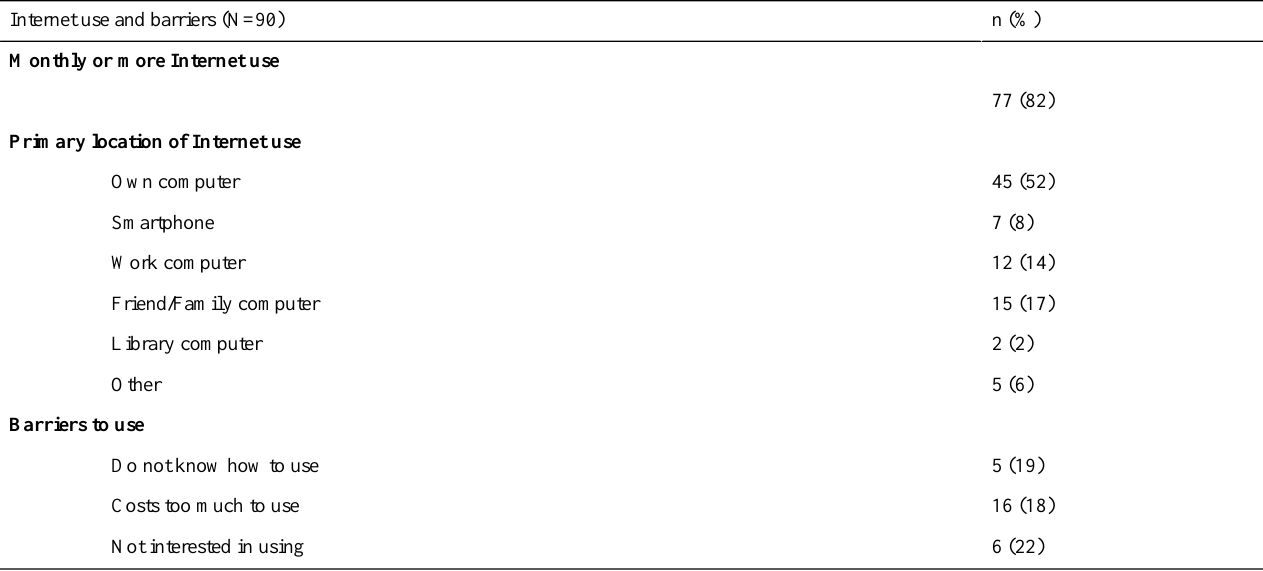
Table 2. Internet use and barriers to use.